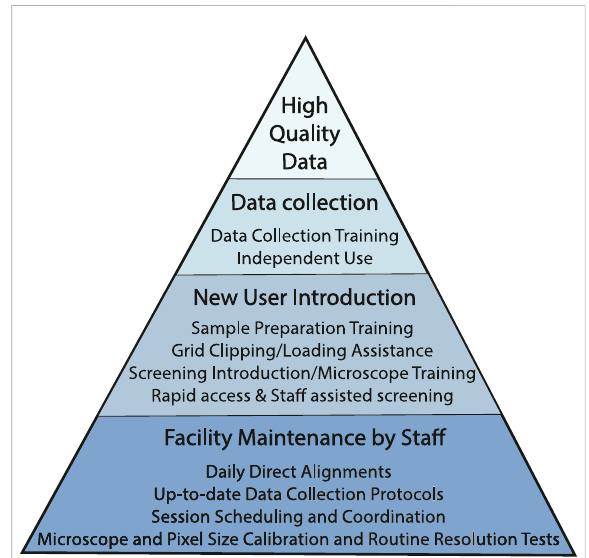
FIGURE 1 User Success Pyramid. Pyramid of steps taken to promote highqualitydatacollectionsforallusers.Atthebaseofthepyramid are routine facility and microscope maintenance tasks to ensure that microscope operation is of the highest standard.